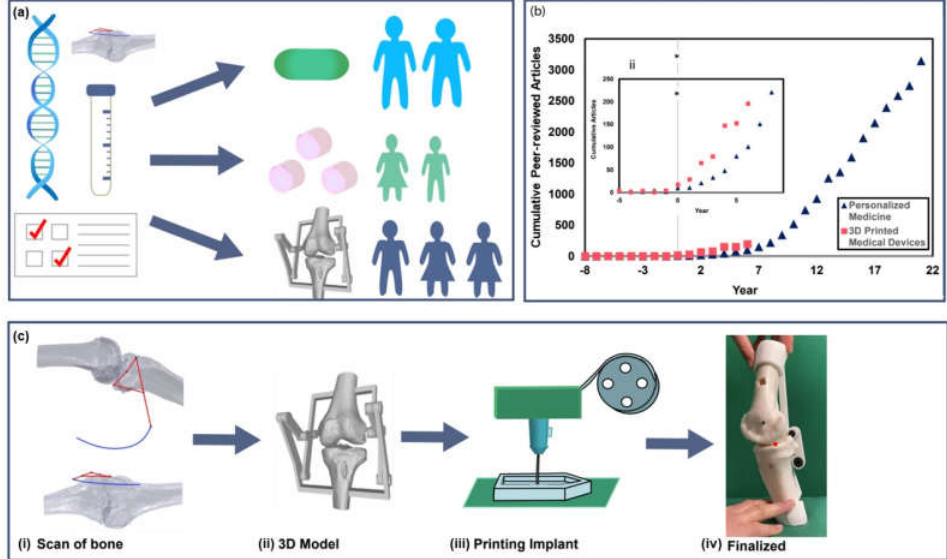
Figure 1. Future outlook for personalized medical treatments. ( a ) Schematic illustration of the application of genetic testing, medical imaging, and diagnostics for creating personalized treatments for a range of patient cases. ( b ) Analysis of cumulative publications on “personalized medicine” (blue) and “3D printed medical devices” (red) compared against a benchmark (* year 0) of 10 paper per year in each field. Inset shows exponential growth in both fields in years 0 through 7 from benchmark. Analysis performed on data collected from Web of Science. ( c ) Example of 3D printed implant models created from CT scans, showing progression from imaging to a patient specific model, followed by printing and an image of a finalized implant. (Images c(i), (ii), (iv) adapted from Mercader et al. 2021 [4] http://creativecommons.org/licenses/by/4.0/ (accessed on December 25, 2021)).